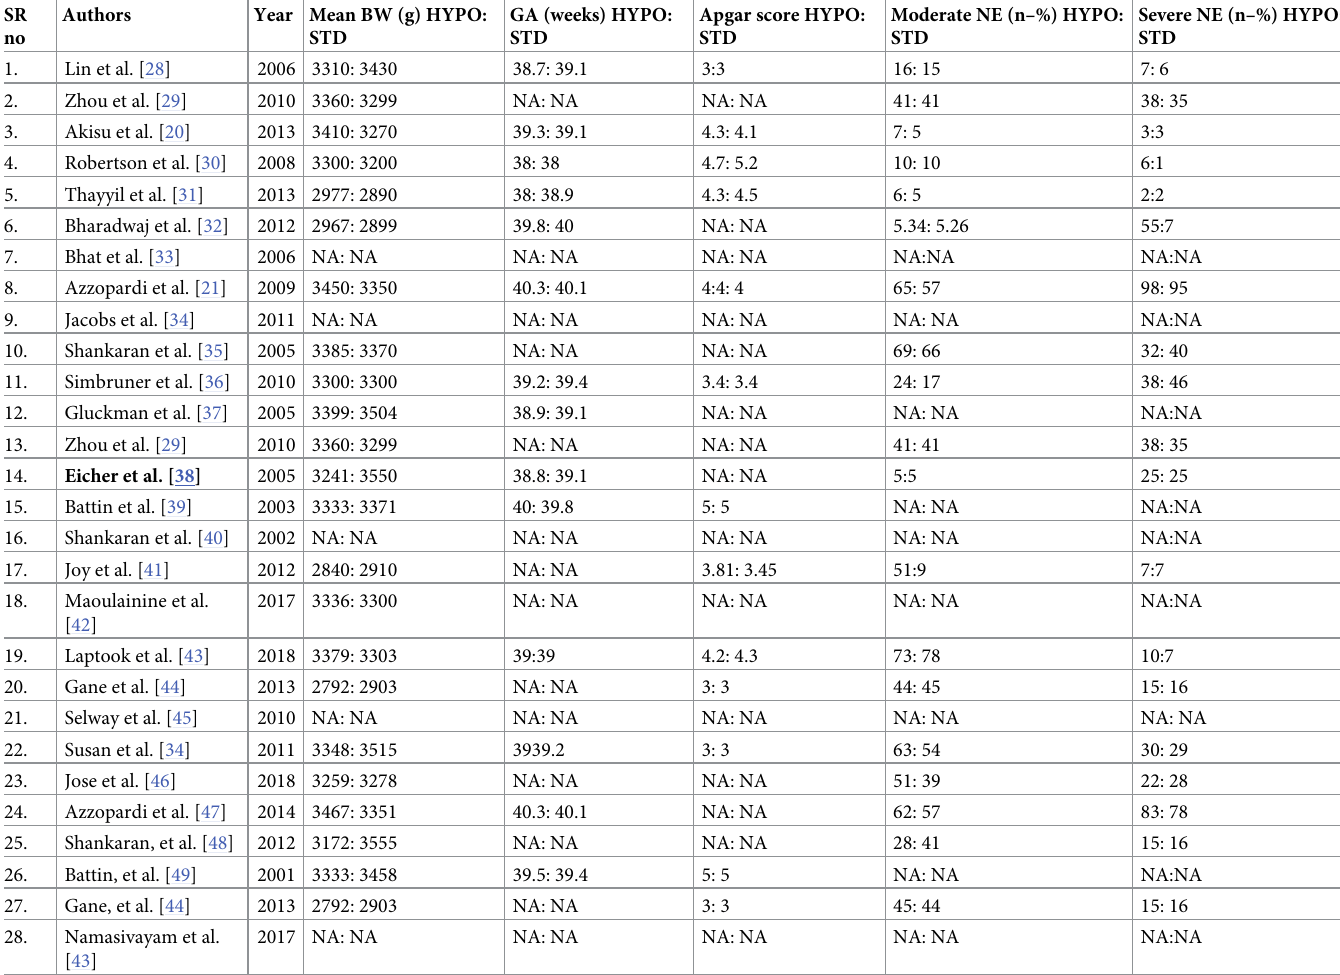
Table 2. Neonatal baseline characteristics of included studies on the effects of therapeutic hypothermia on death among asphyxiated neonates with hypoxic-ische- mic